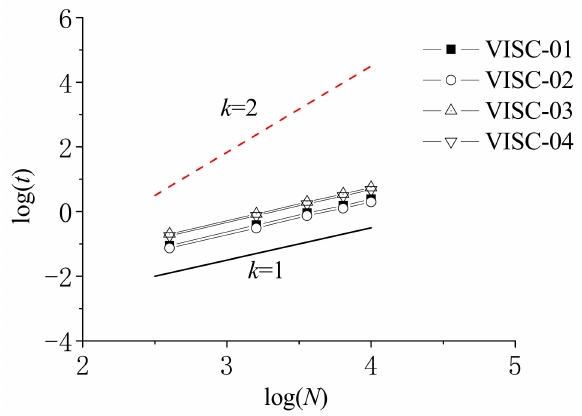
Figure 6. Convergence analysis of CPU time for different viscosity force models under the non-uniform particle